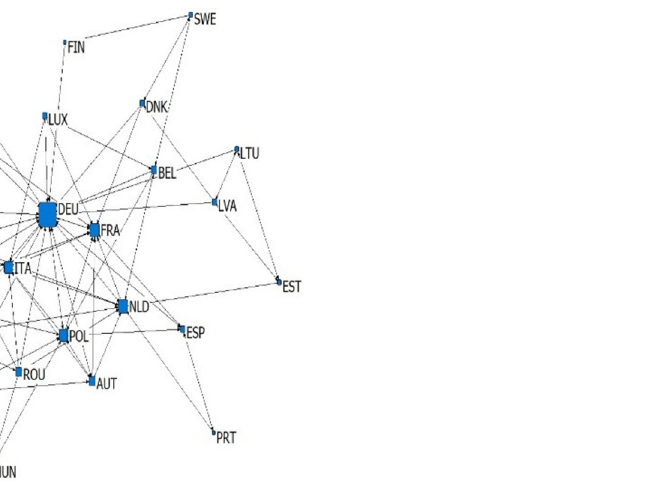
Fig 5. Horizontal intra industry export dependence network.